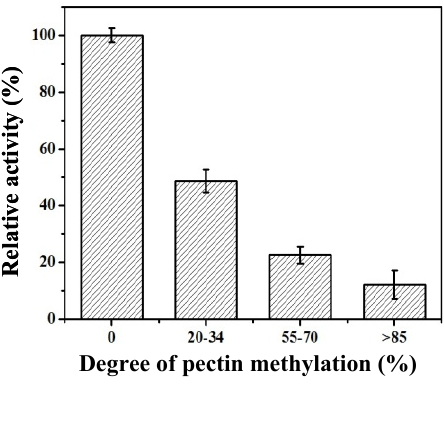
Figure 6. Effect of the degree of pectin methylation on CbPelA activity. Mean (SD) was calculated from three independent